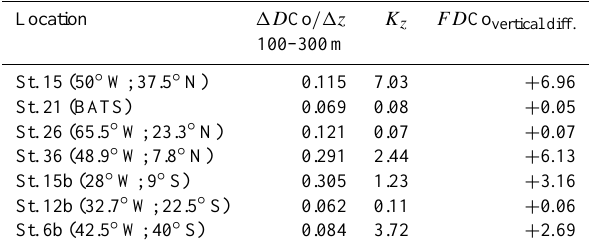
Table 5. Vertical dissolved cobalt gradient ( 1D Co /1z